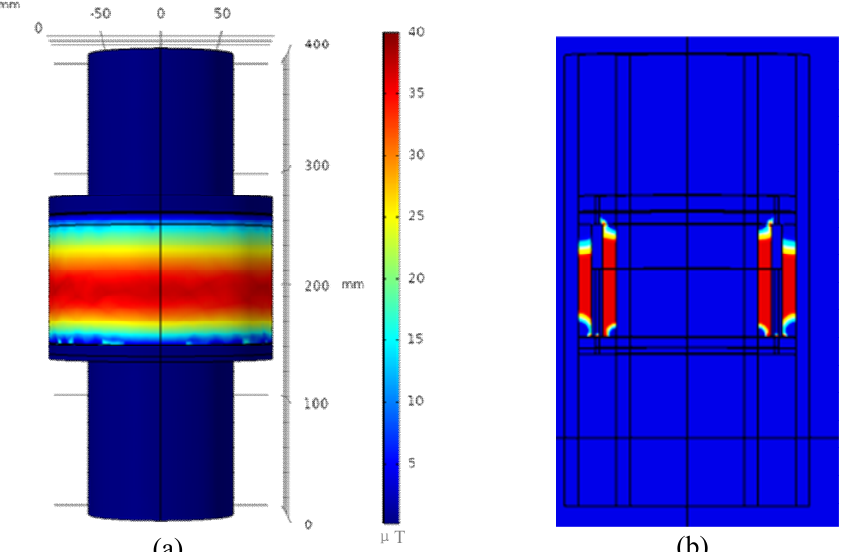
Figure 4. The simulated magnetic field distribution: ( a ) The simulated magnetic field distribution of primary side coupling mechanism; ( b ) the simulated magnetic field distribution of the whole system.